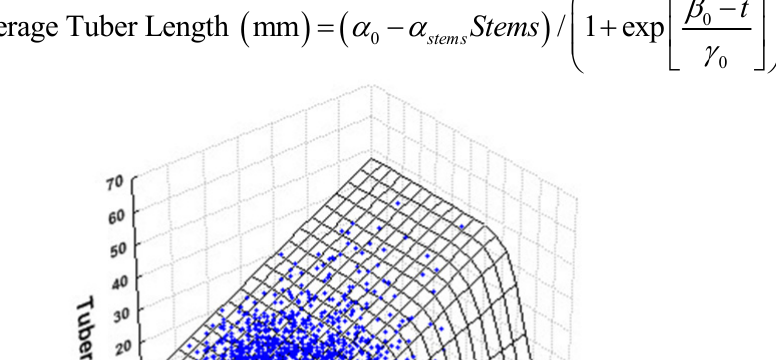
Figure 3. Observed (points) and estimated average potato tuber number (smoothed